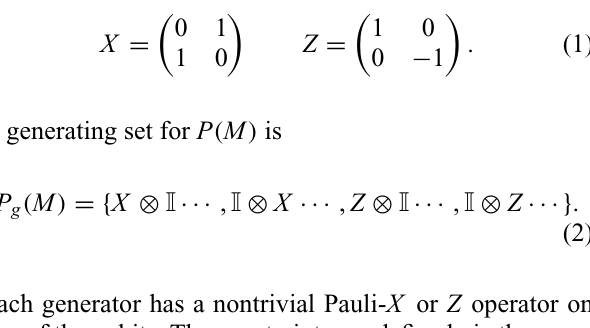
FIG. 1. A stratification of three-dimensional space. The space is stratified into 3 strata (orange blocks), 2 strata (blue planes), 1 strata (magenta lines), and 0 strata (black dots). The thin black lines show the finer lattice inside the 3 strata. 3+1D TQFT lives on each 3 stratum. 3 strata are coupled together by lower-dimensional defects (2 strata, 1 strata, 0